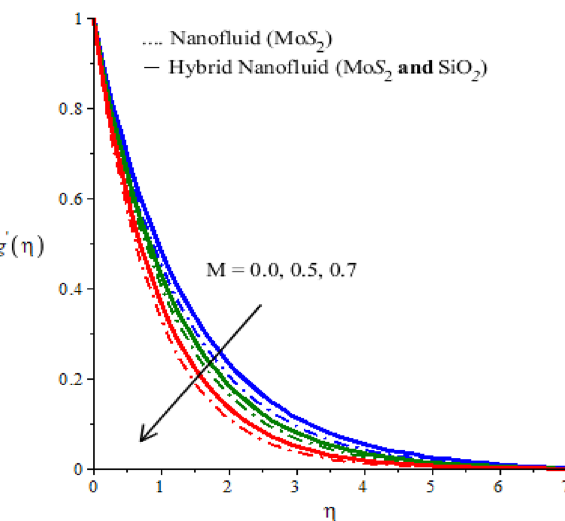
Figure 5. Vertical velocity profiles of mono nanofluid (dotted curves) and hybrid nanofluid (solid curves) for M when Pr = 204, (cid:31) E = 0.5, h s = 1.7, n = 2, φ